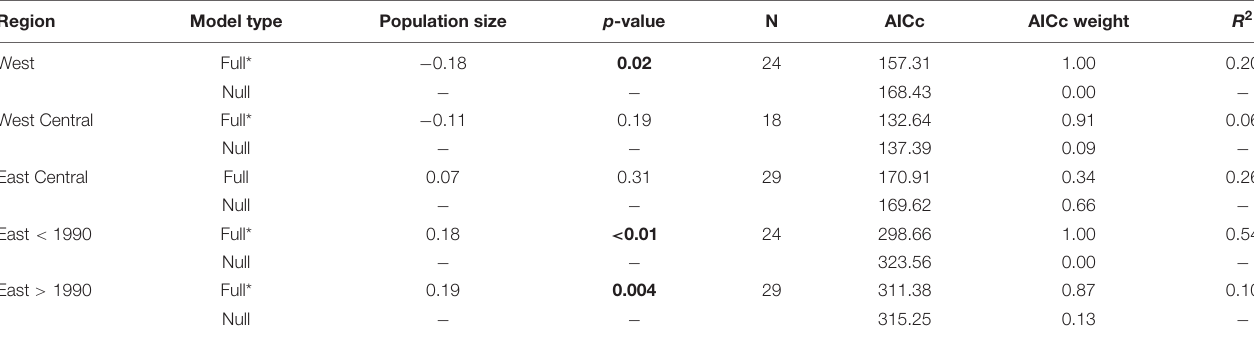
TABLE 2 | Parameter estimates for Generalized Linear Models of the relationship between population size (explanatory variable) and the number of non-zero distance band recoveries (response variable) in four North American sub-populations of Ring-billed Gull. Region Model type